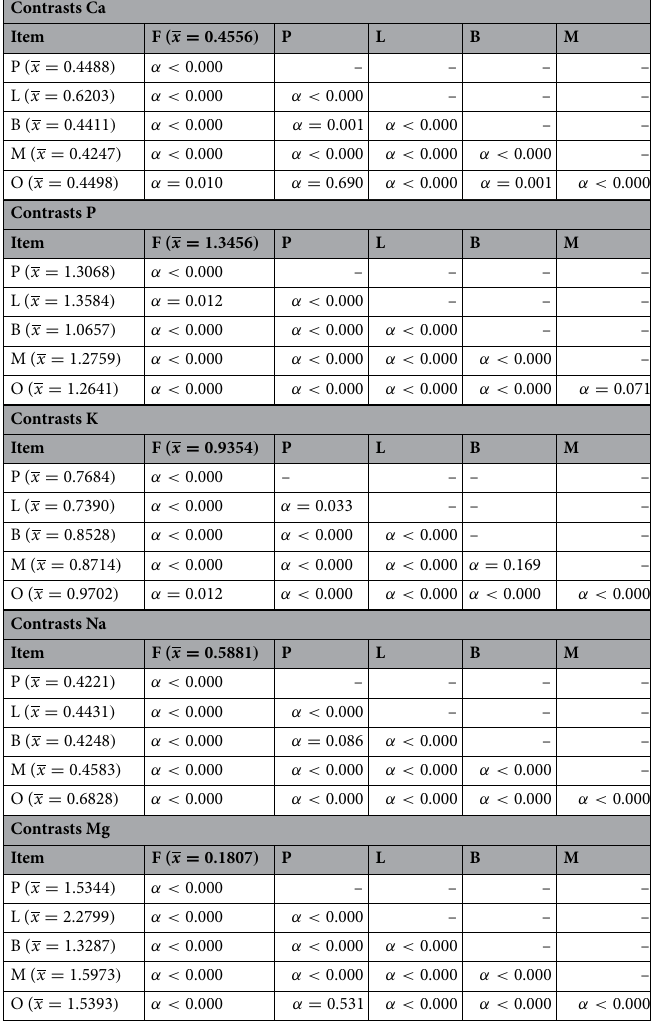
Table 2. Comparison of the means determined for the analyzed groups of dry dog foods based on linear contrasts. F, foods with fish; P, foods with poultry; L, foods with lamb; B, foods with beef; M, mixed foods; O, other